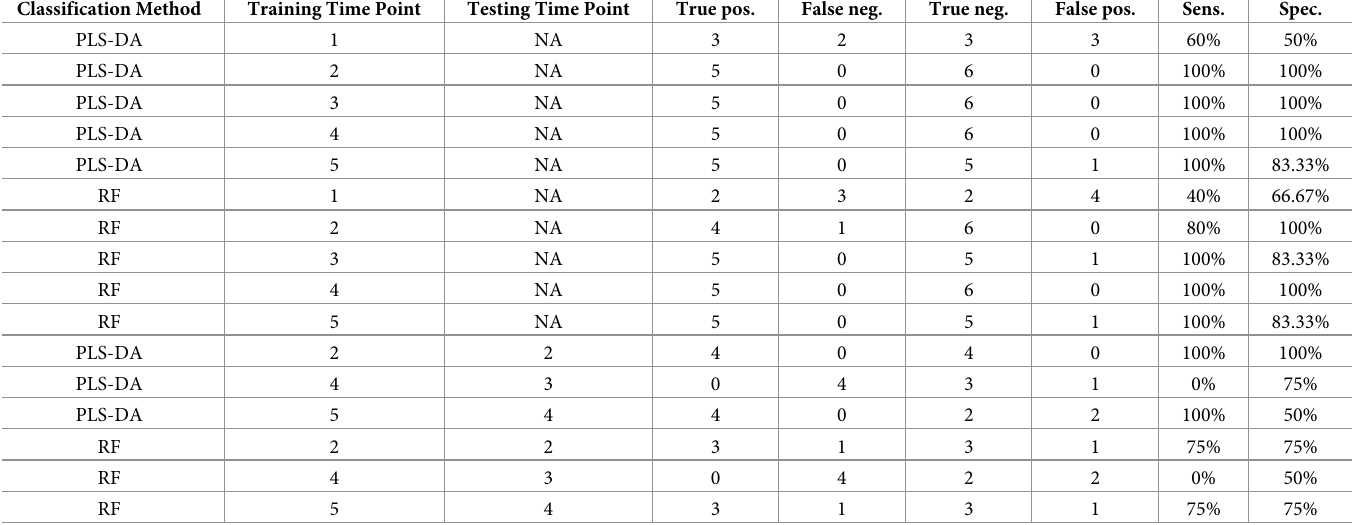
Table 3. Binary classification for the 7 metabolite model. These values were derived from multivariate exploratory ROC analysis with PLS-DA or RF as the final classifi- cation methods. The 7 metabolite model is composed of tyrosine, tryptophan, threonic acid, pseudouridine, taurine, xylitol, and lyxitol. Sens, sensitivity; Spec, specificity. When both training and testing time points are listed, the model is trained using data from training time point and used to predict the testing time point classifier (i.e treated vs control). Classification